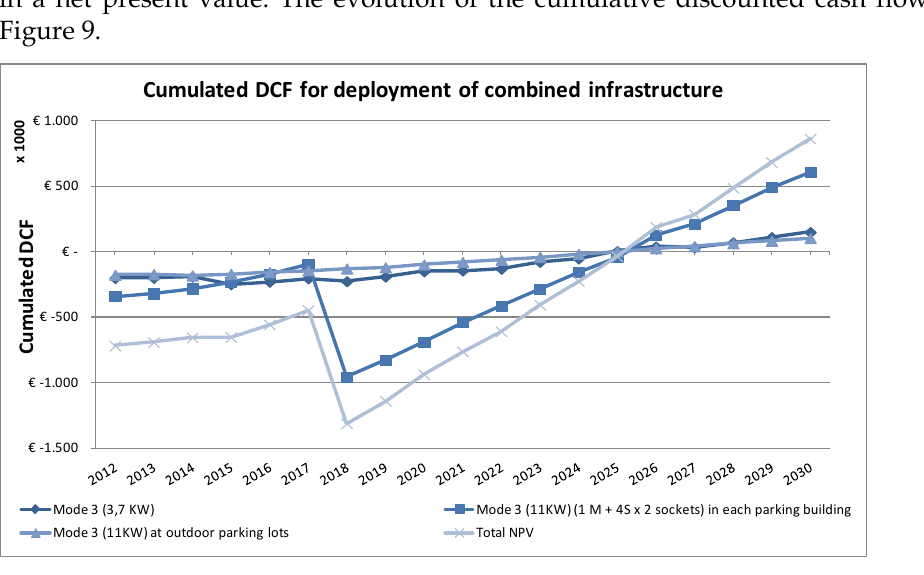
Figure 9. Evolution of the cumulated DCF for the private parking facility provider (scen. C) From the analysis above, a steady growth in Discounted Cash Flows (DCF) can be noticed,